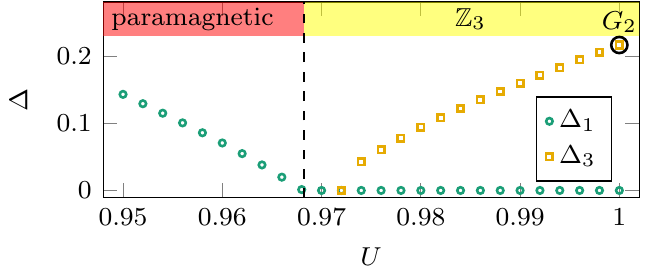
(cid:112) 3 (see dashed line close to > 0). In contrast, in the 3 > 0). The transition (determined 1 ≈ 0.97. The gap ∆ c